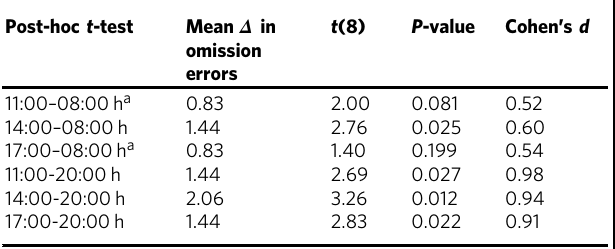
Table 3 Repeated measures ANOVA post-hoc t -tests on omission errors Post-hoc t -test